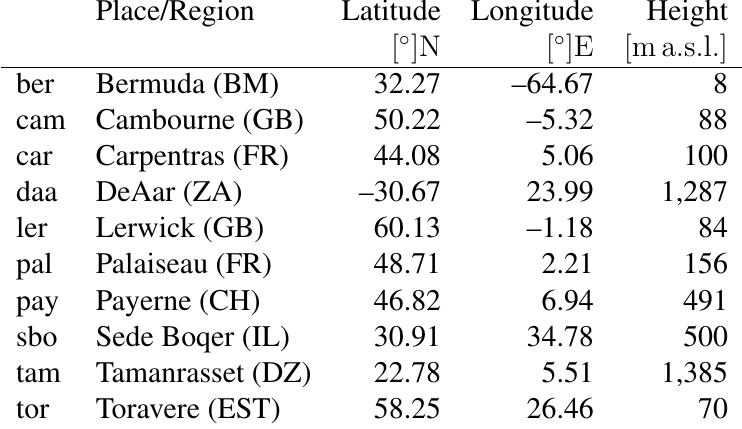
Table 1. Relevant BSRN stations present on the Meteosat full disk for the years 2004 to